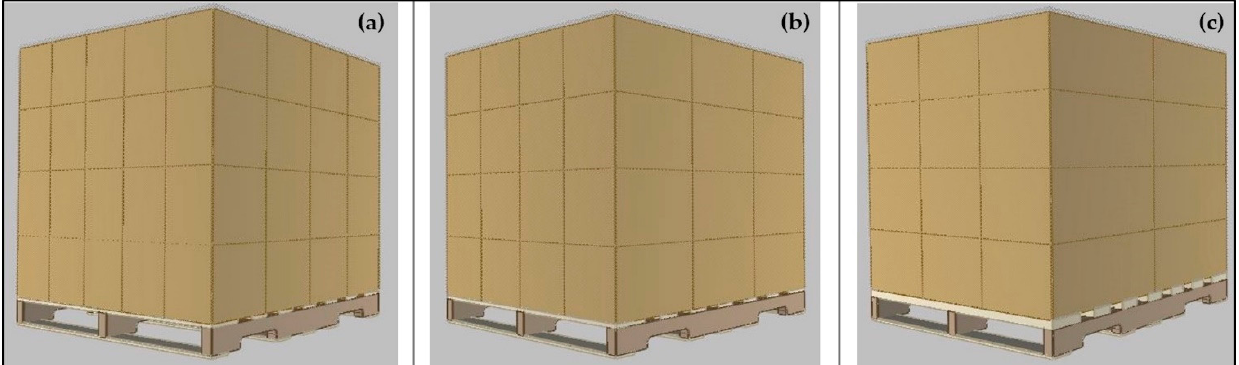
Figure 2. Image of investigated unit load configurations (image generated using PDS™). ( a ) Unit load with small boxes, ( b ) unit load with medium boxes, and ( c ) unit load with large boxes.